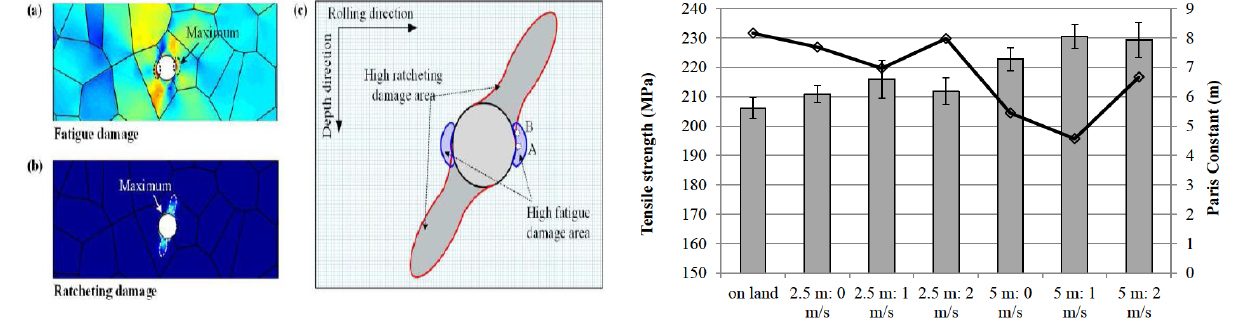
Figure 14: Mechanism of crack propagation around the inclu- sion [23].